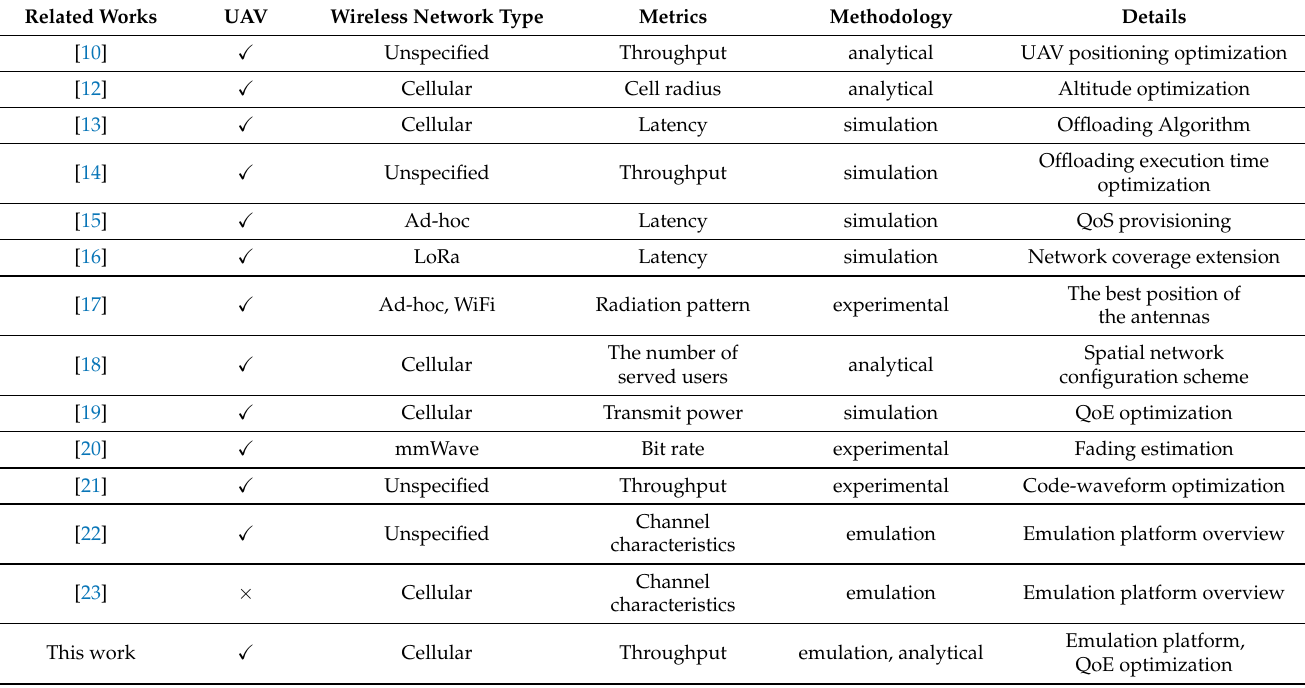
Table 1. Selected works in